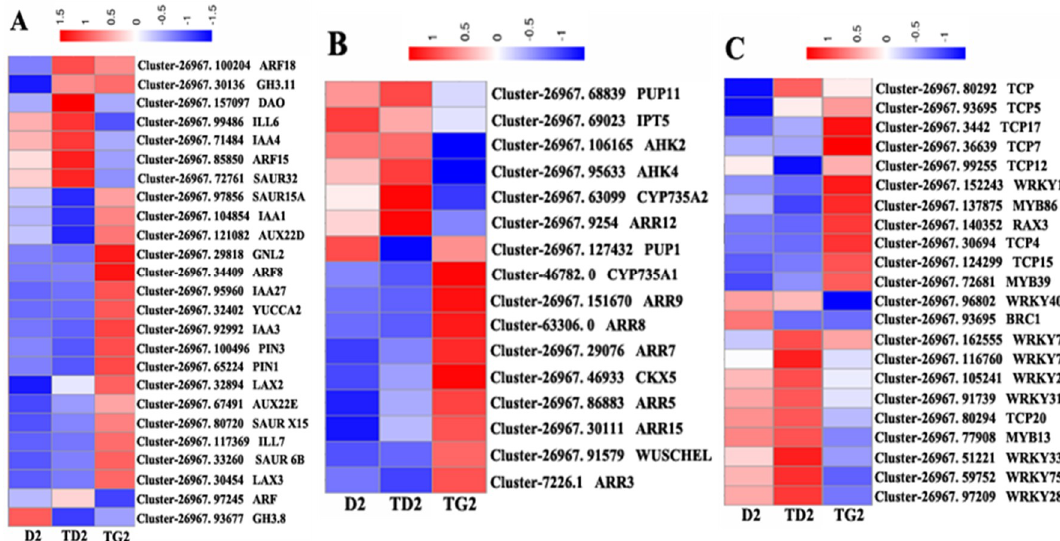
Figure 6. Hierarchical cluster analysis of auxin- ( A ), cytokinin- ( B ), and transcription factor-related ( C ) DEGs during lateral bud elongation in C. appendiculata . Red indicates high relative gene expression and green indicates low relative gene expression.